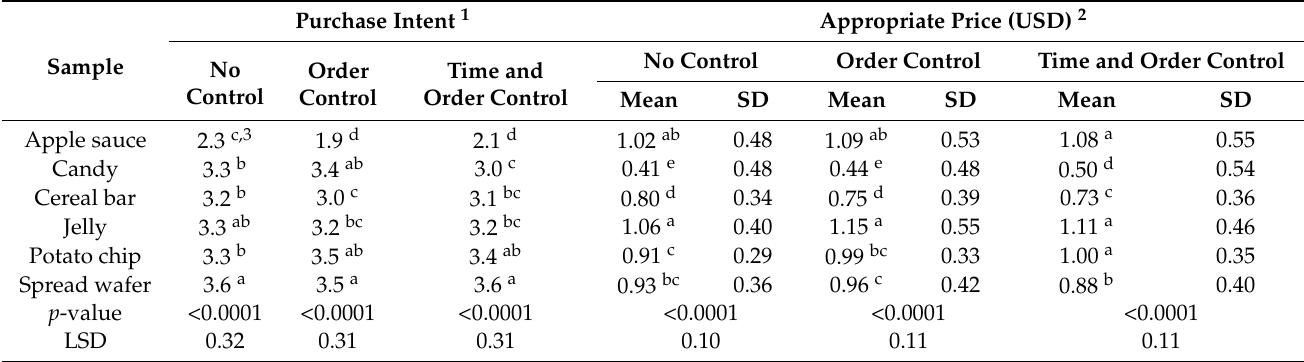
Table 9. Purchase intent and price willing to